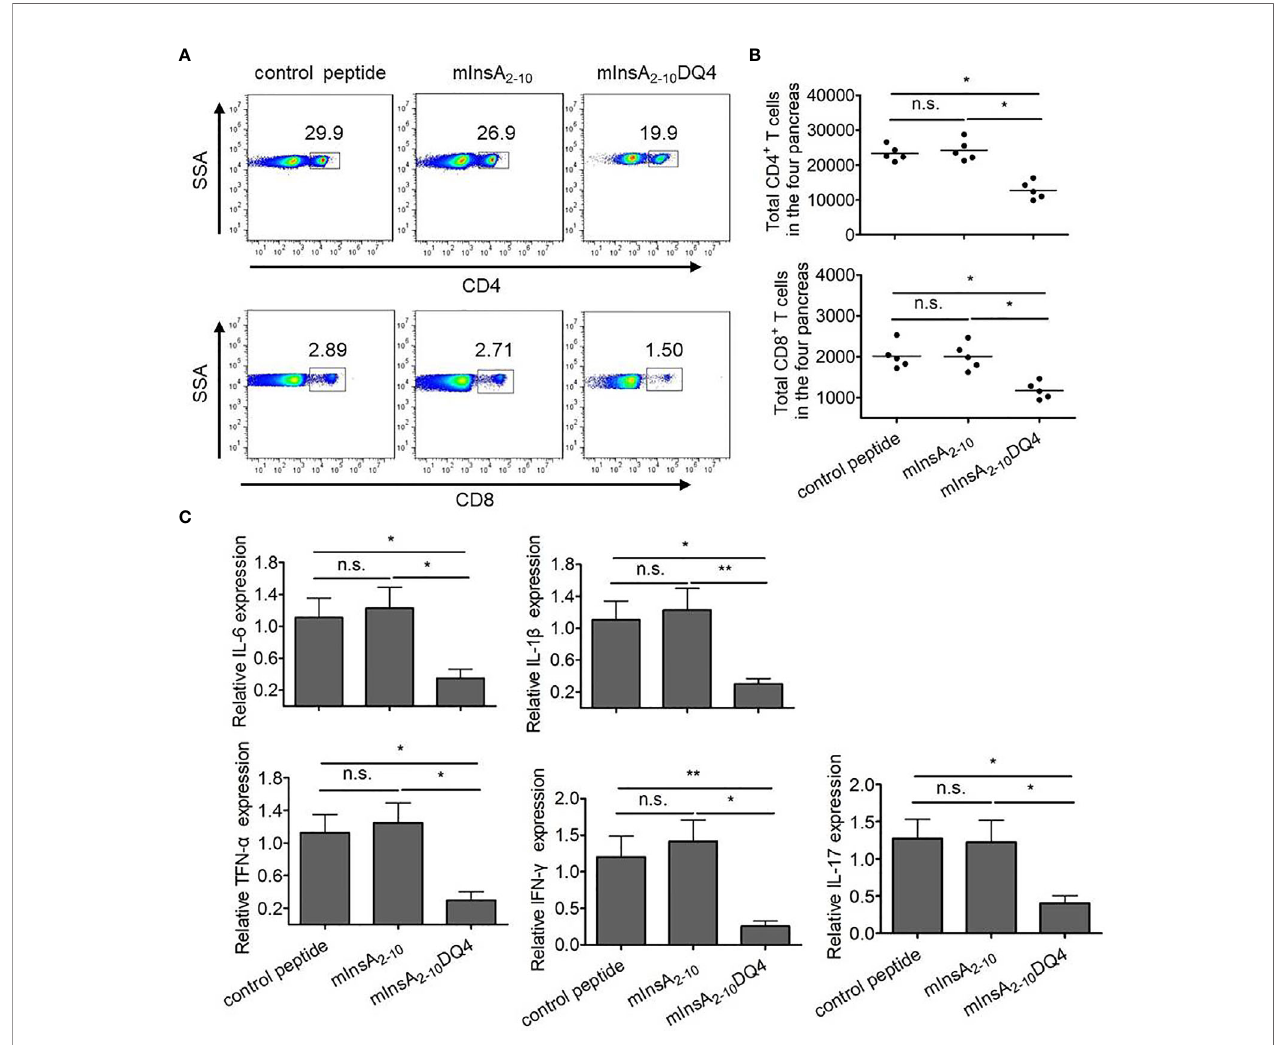
FIGURE 6 | Treatment with mInsA 2-10 DQ4 notably reduced frequencies and absolute numbers of pancreas-in fi ltrating CD4 + T and CD8 + T cells in NOD. b 2 m null .HHD mice. (A) Representative fl uorescence-activated cell sorting (FACS) histogram plots for pancreas-in fi ltrating CD4 + T and CD8 + T cells from four mice. (B) The results for absolute numbers of these pancreas-in fi ltrating CD4 + T and CD8 + T cells are expressed as the mean ± SD. Each symbol in (B) represents a sample of pooled pancreas-in fi ltrating CD4 + T and CD8 + T cells from four mice. (C) Total RNA was extracted from the pancreas in each peptide-treated group of non-diabetic mice (n = 6). The mRNA expression levels of these cytokines were quanti fi ed by real-time RT-PCR. The data are presented as fold-change compared to the mRNA levels expressed in pancreas from control peptide-treated mice. *P < 0.05 and **P < 0.01. n.s. indicates no signi fi